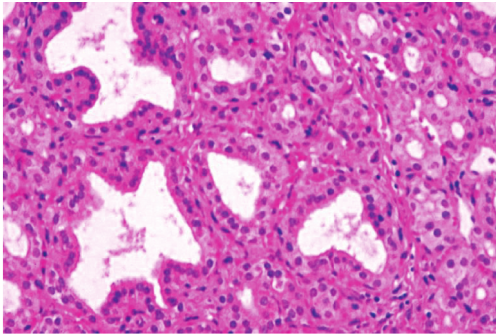
Figure 9: Thyroid sections folded empty follicular structures asso- ciated with embryonic aspect rounded follicles. Pyknotic interstitial and follicular nucleus are present in ewes, H&E,